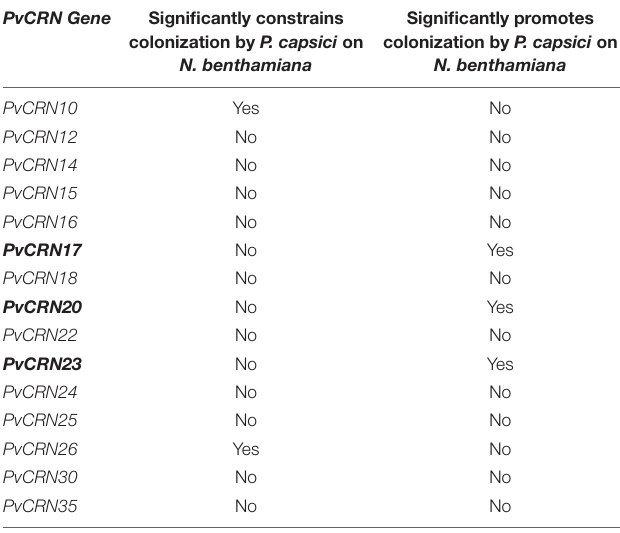
TABLE 5 | The effect on the resistance of N. benthamiana to P. capsici of selected PvCRNs. PvCRN Gene